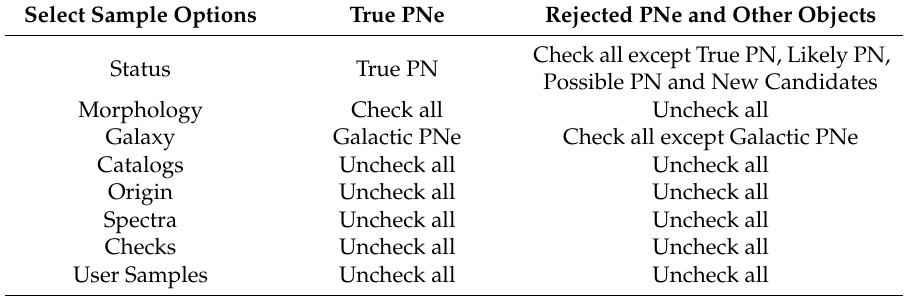
Table A1. Query submitted to obtain True PNe and Rejected PNe alongside other objects from HASH DB. Select Sample